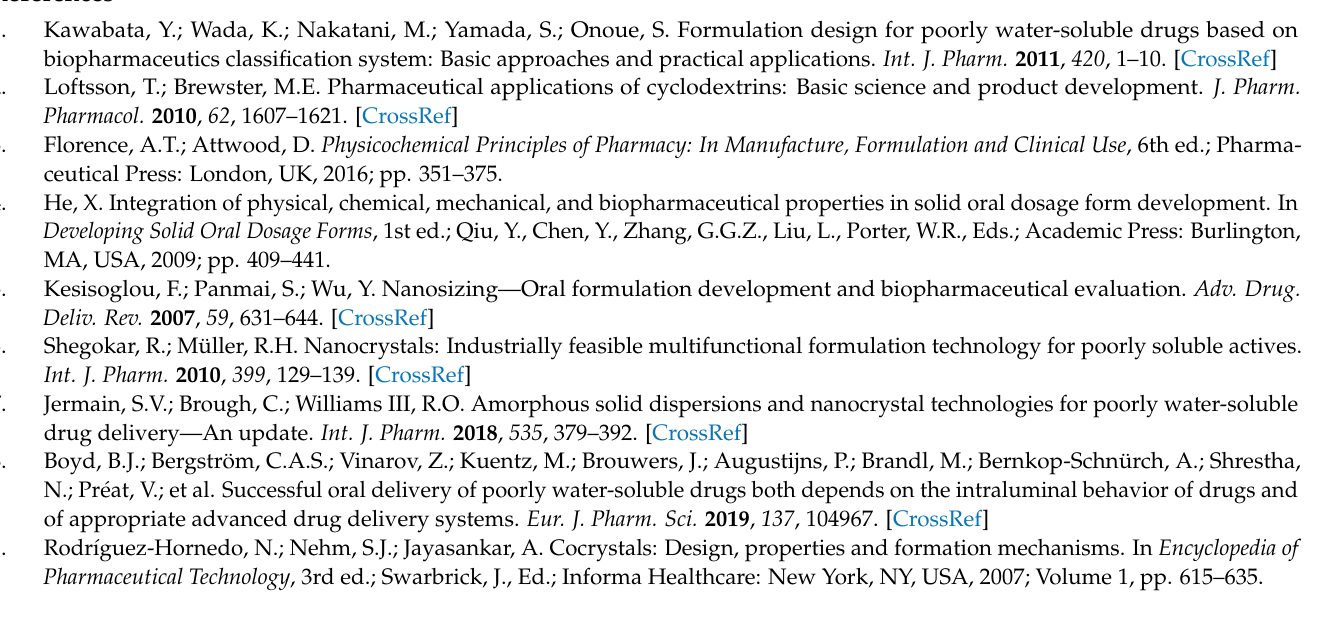
NPX/PA in (a) pH 5.0 buffer and (b)